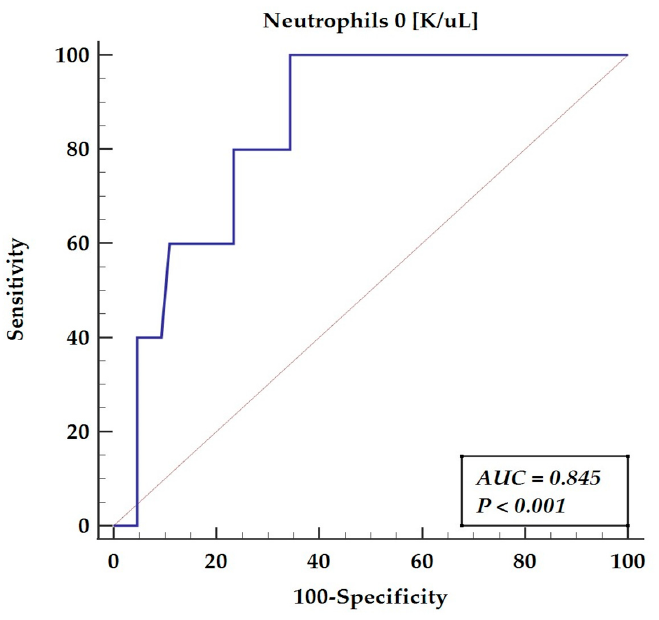
Figure 2. Receiver-operating characteristics for AV block disturbances. Abbreviations: AUC—area under the curve.